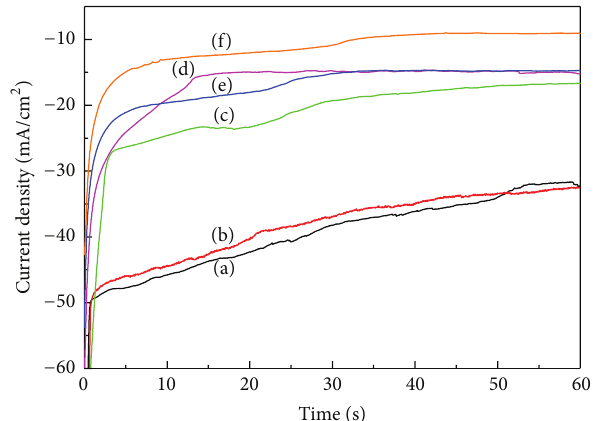
Figure 2: I - T curve of thin films under different potentials (a) − 1950 mV, (b) − 1750 mV, (c) − 1550 mV, (d) − 1350 mV, (e) − 1150mV, and (f) − 950 mV.